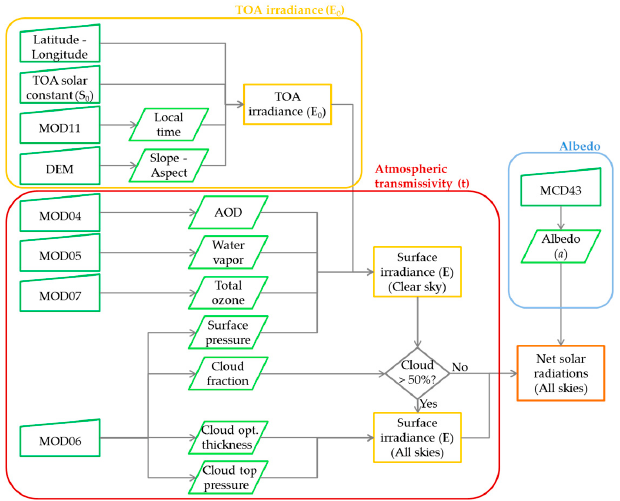
Figure 3. Computation of the instantaneous solar radiation budget for all skies using MODIS products and a DEM.